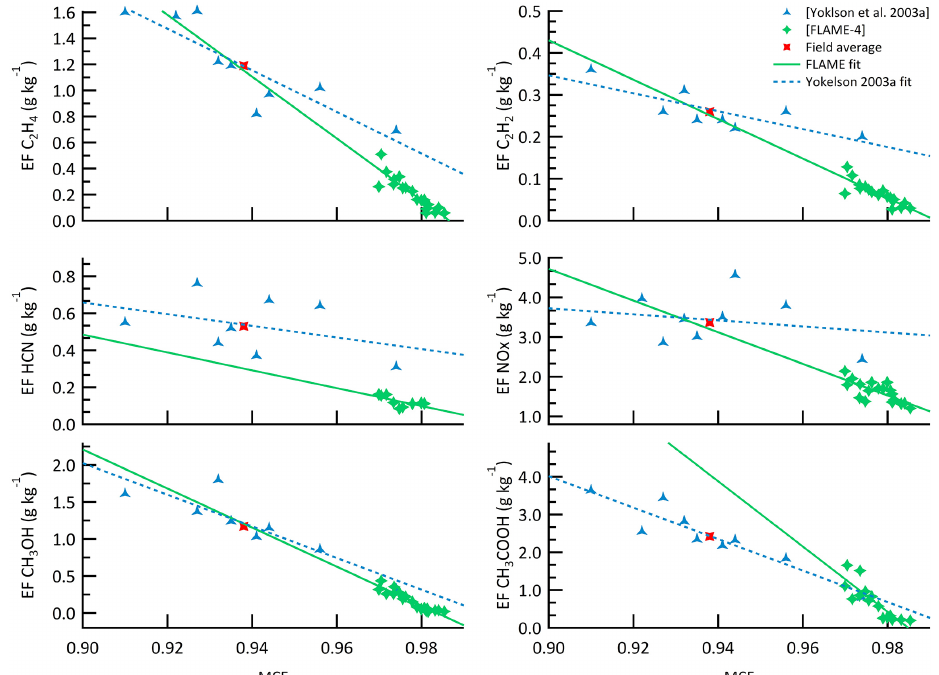
Figure 5. Comparison of EFs vs. MCE between FLAME-4 laboratory African grass fires (green) and airborne field measurements of African savanna fires (blue) for specified hydrocarbons, selected nitrogen-containing species, and specified oxygenated species. Lines indicate linear regression of lab-based (green solid line) and airborne (blue dashed line) measurements.